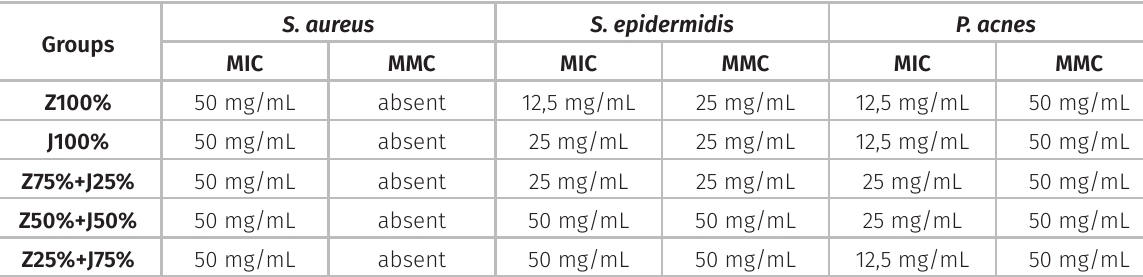
Table II. MIC and MMC promoted by Z. officinalis and J. regia extracts.